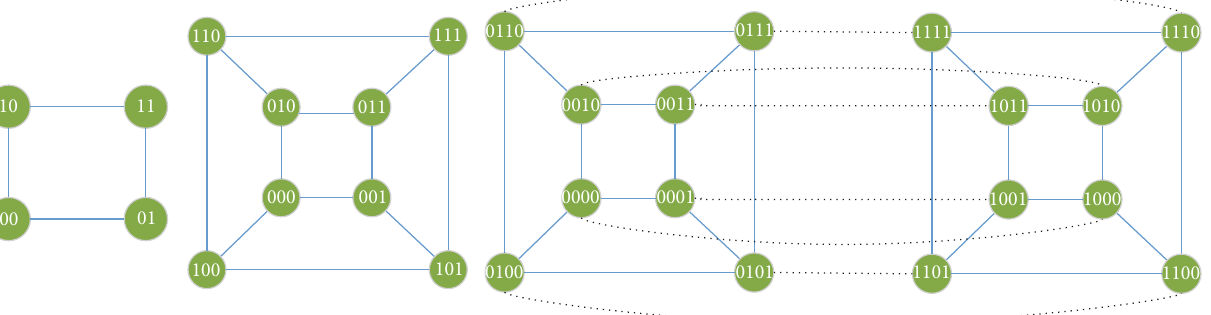
Figure 1: Three examples of 𝐻 𝑛 .